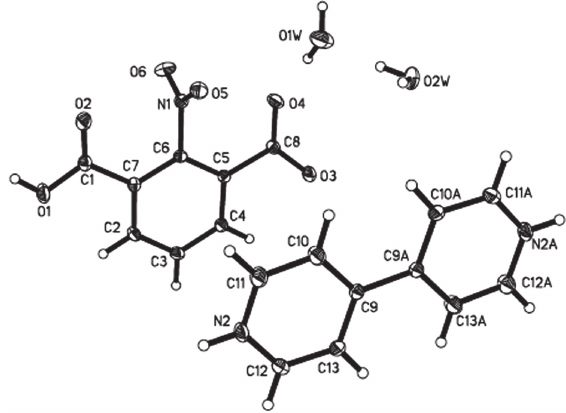
Table 2: Fractional atomic coordinates and isotropic or equivalent isotropic displacement parameters (Å 2